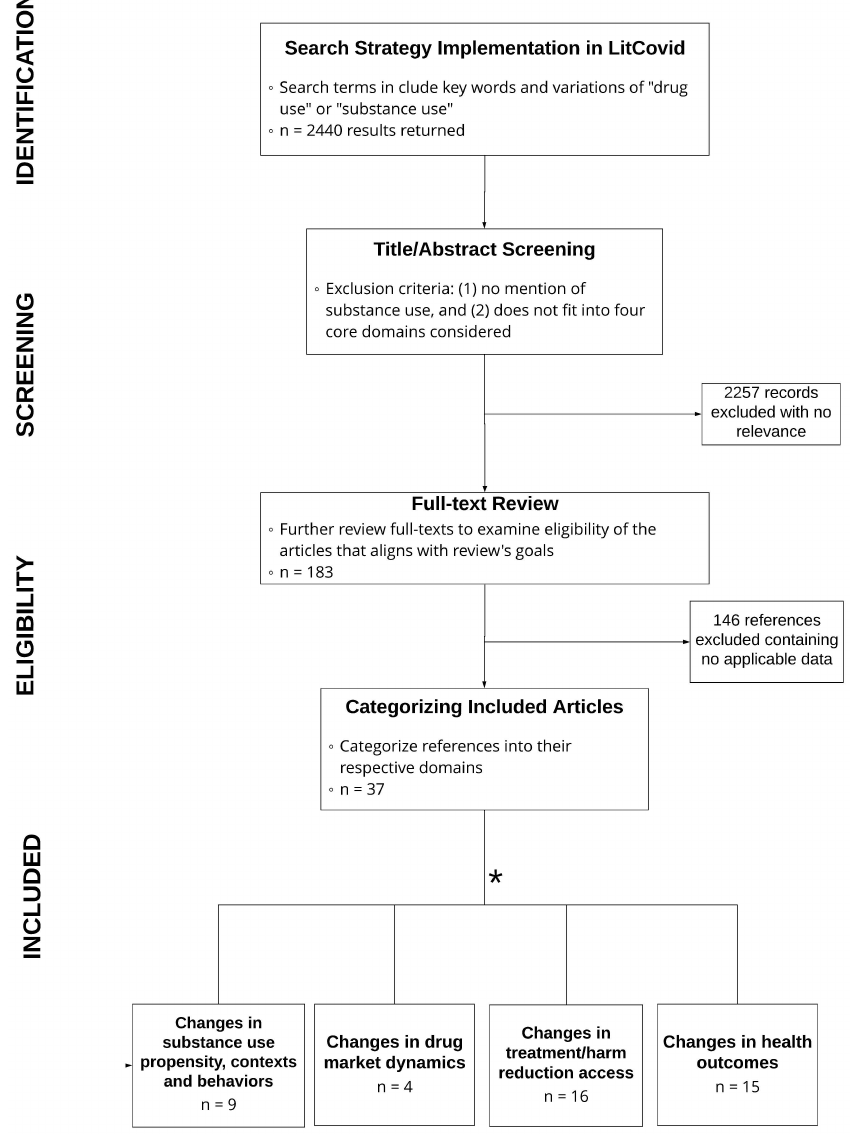
Figure 1. PRISMA literature review process. * Final categories for included articles are not mutually exclusive and articles may be classified in one or more